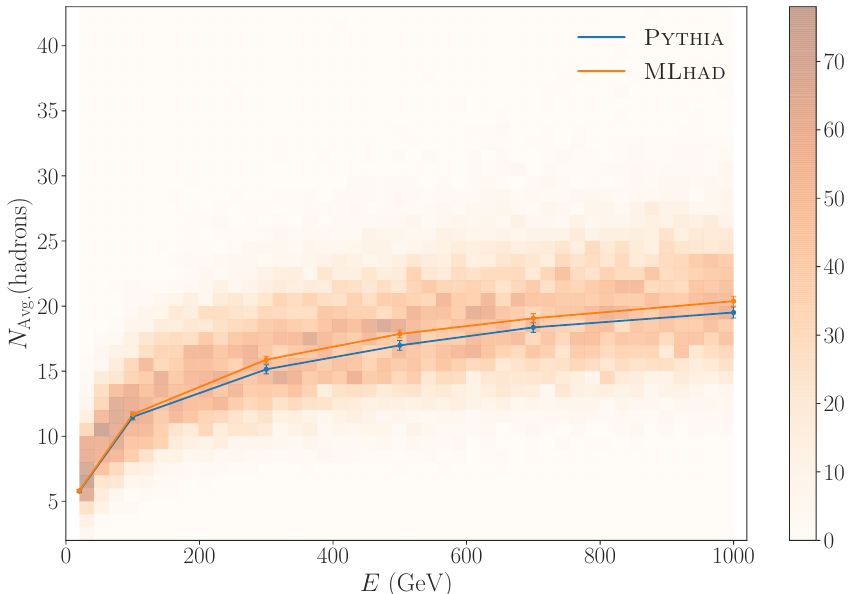
Figure 12: Comparison of the average number of hadrons produced in the fragmenta- tion chain of a single string as a function of the initial parton energy E ( E produced using P YTHIA (blue) and ML HAD (red). The density plot shows the multi- plicity distributions obtained with ML HAD for 2 × 10 4 fragmentation